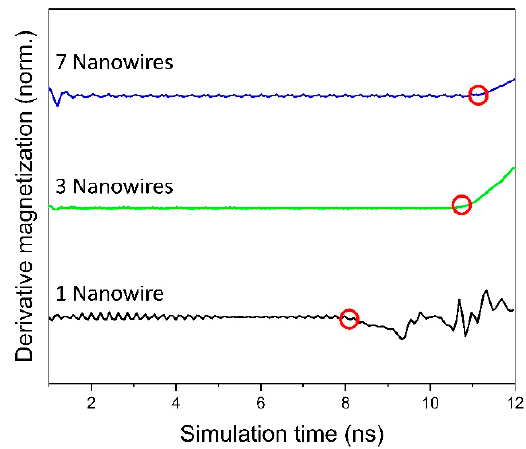
Figure 6. Derivative of the magnetization along the wire’s length ( M x ) during the current pulse in the case of 1, 3, and 7 nanowires. Red circles show the moment of the depinning of the domain wall.